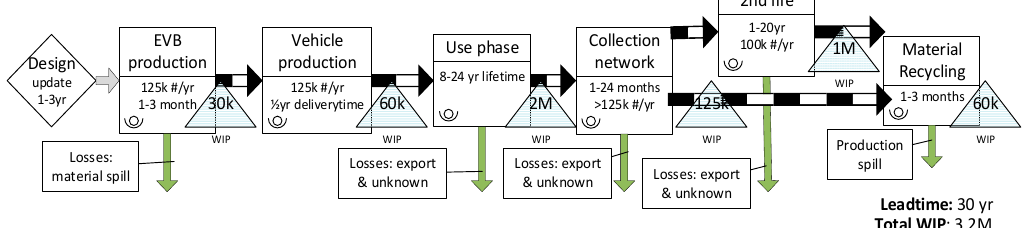
Figure 4. Value-stream map overview of the projected design to recycling, with Swedish data.